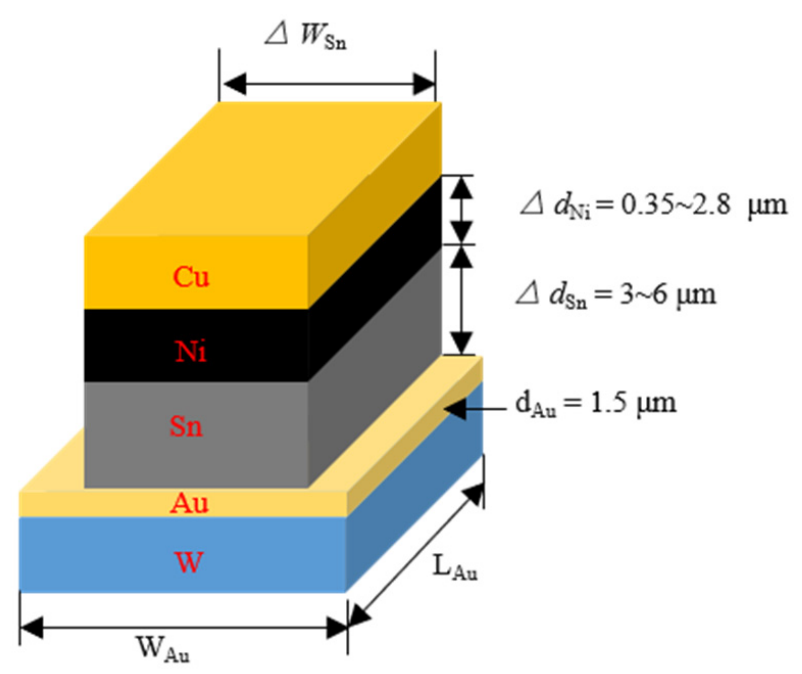
Figure 1. ( a ) Schematic structure of AlN RF filter WLP. ( b ) Top view of the capping wafer.